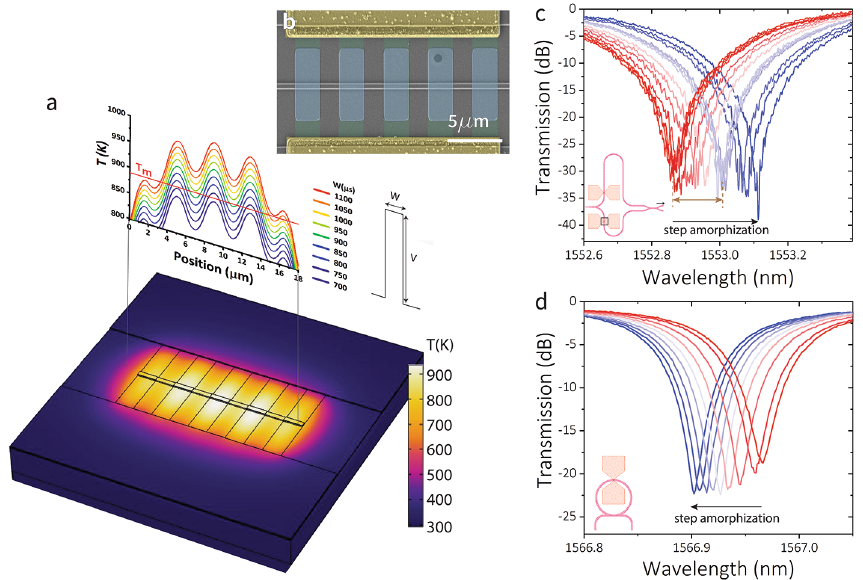
Fig. 5 Engineering microheater to achieve partial amorphization. a FEM heat transfer simulation of a microheater consisting of five 2 μm-wide ‘bridges’. The temperature profile along the waveguide is plotted for different pulse widths. b Colored SEM image of a fabricated device. c Partial amorphization of the bottom arm Sb 2 Se 3 in an un- balanced MZI. 10.8 V pulses with varying widths between 800 ns and 1050 ns were employed to amorphize and 3.2 V for 1 ms to fully crystallize. The transmission is measured in the top output waveguide where a maximum of π/2 phase shift is observed, corresponding to the full amorphization of the three central ‘bridges’. Reversible switching is demonstrated over three cycles between the full crystalline state and the marked intermediate state (corresponding to a 900 ns pulse). d The same phase shifter with partial amorphization in a micro-ring